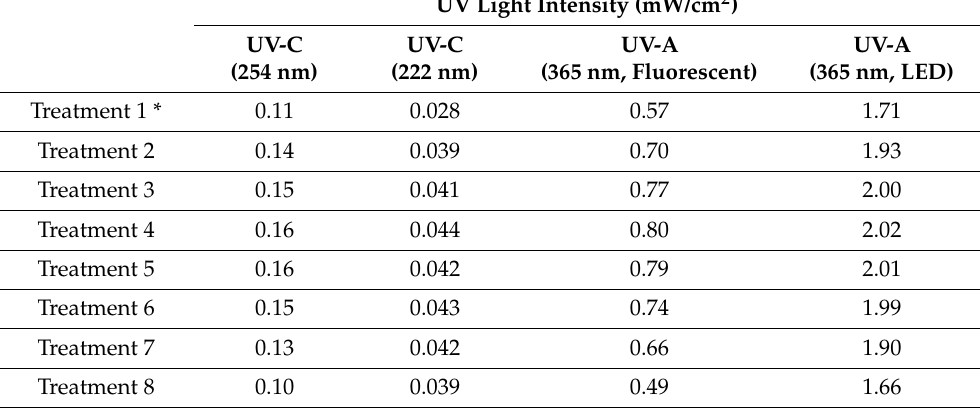
Table 1. Average UV light intensity for each treatment (quartz tube #) measured without tube shielding. In the experiment, the quartz tubes were covered with different lengths of polyvinyl chloride (PVC) pipes to control the UV dose, and thus, the effective light intensity was estimated for each treatment separately.